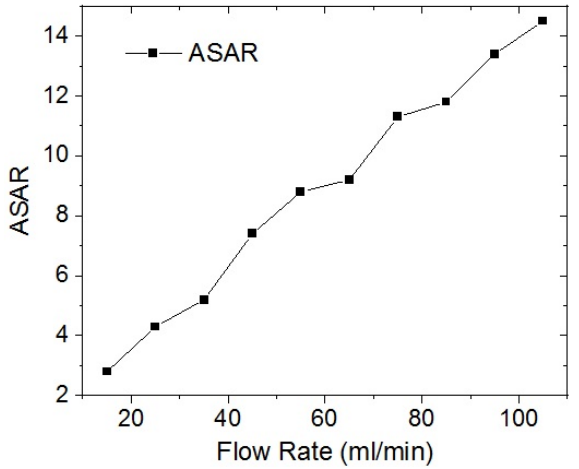
Figure 8. ASAR as a function of flow rate (0.4 M, 1.2 V).